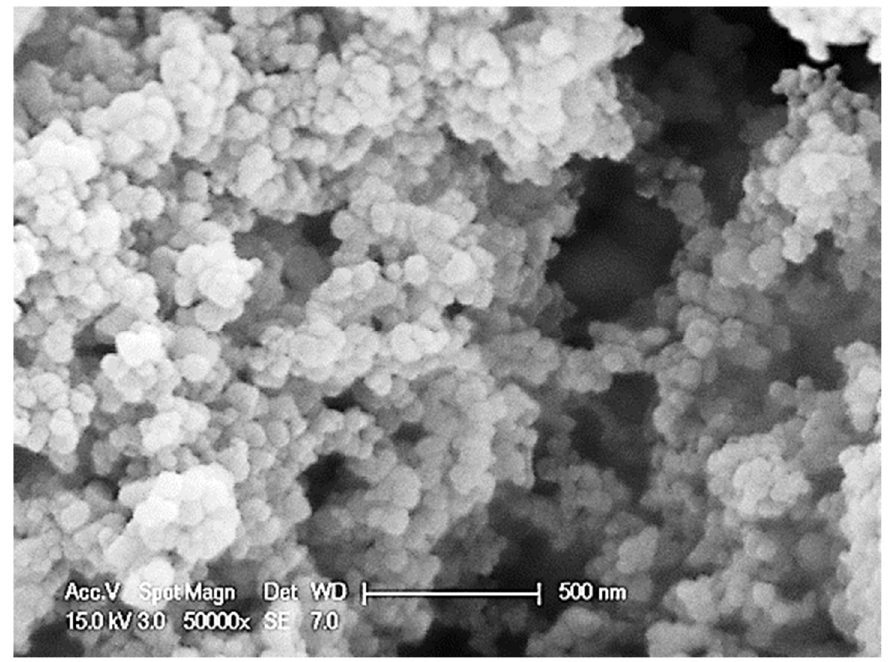
Figure 1. Scanning electron microscope image of magnesium-calcium carbonate nanoparticles (Mg-CaCO 3 ) at magnification 50,000 .